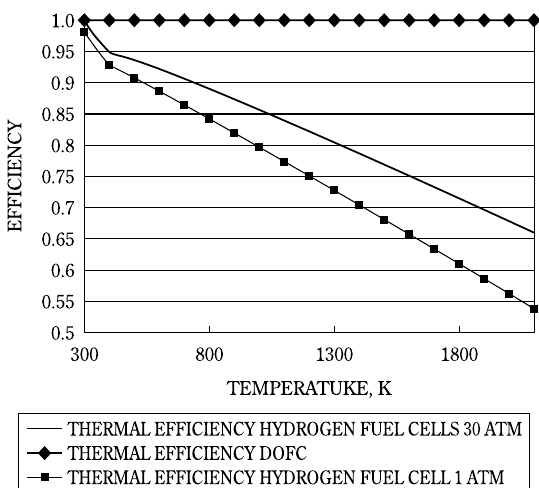
Fig. 2 Fuel Cell maximum intrinsic thermal efficiency. DCFC thermal efficiency is 1.0 at all